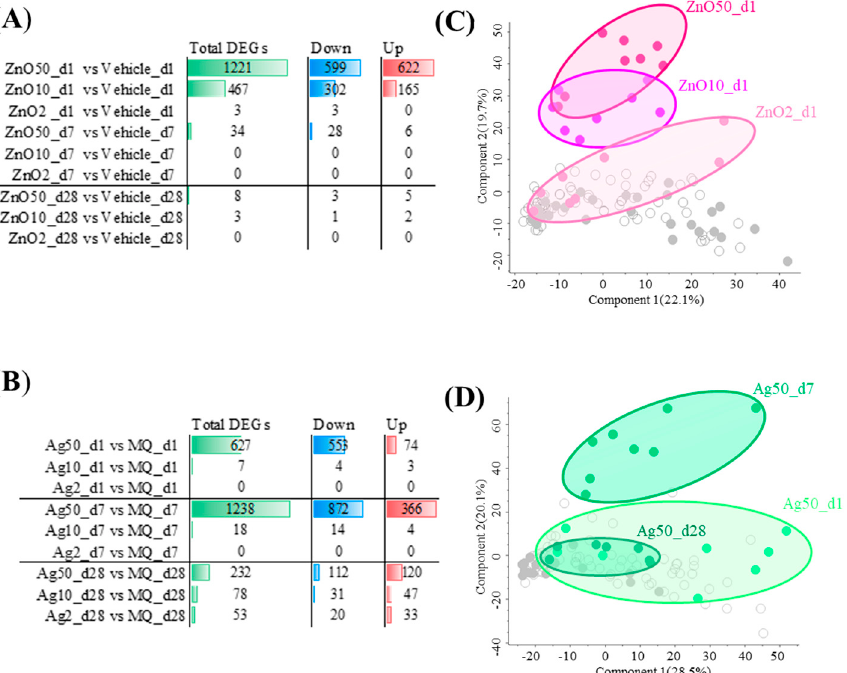
Figure 2. Exposure to nZnO and nAg causes varying numbers of differentially expressed genes (DEGs) in mouse lung tissue and induces changes in associated principal component analysis (PCA). The exposure to ( A ) nZnO or ( B ) nAg yielded a different number of total DEGs, which were either up- or down-regulated. When a fold change was ≥ |1.25| and Benjamini-Hochberg adj. p -value was ≤ 0.05, DEGs were considered significantly different. The first two components are shown in ( C ) for nZnO and in ( D ) for nAg in PCAs. In ( C ), dark red filled circles represent 50 μ g of nZnO, red 10 μ g of nZnO, and light red 2 μ g of nZnO 1 day after the exposure. In ( D ), dark green filled circles represent the exposure after 1 day, green represents the exposure after 7 days, and light red represents the exposure after 28 days to 50 μ g of nAg.